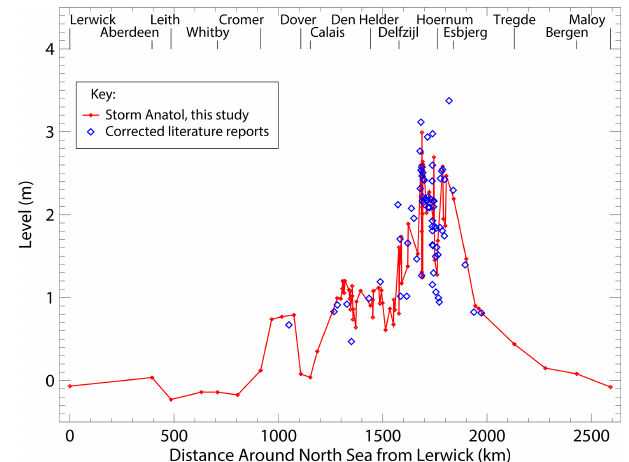
Figure 6. Skew surge during Storm Anatol on 3–4 December 1999. The values are calculated from tide gauge records and arranged by counter-clockwise distance around the North Sea starting from Ler- wick in Scotland. Literature reports are included for comparison.